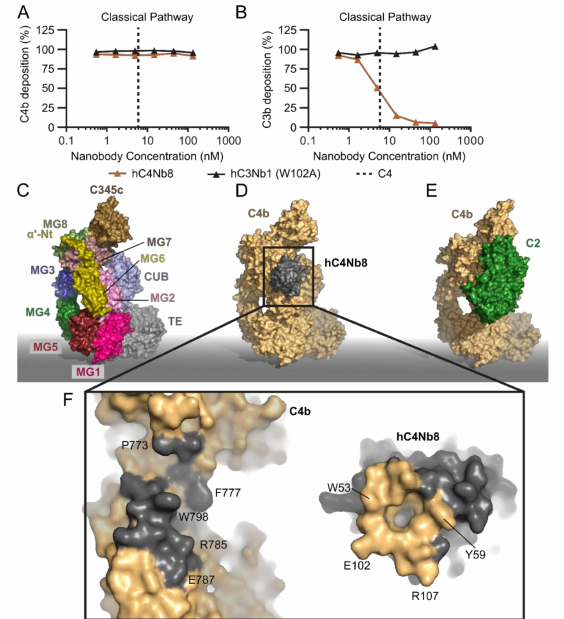
Figure 4. The inhibition mechanism of hC4Nb8. ( A , B ) Effect of hC4Nb8 on C3b and C4b deposition in 0.2% NHS where the CP was activated by heat aggregated IgG. hC4Nb8 potently inhibits C3b deposition without interfering with C4b deposition. The inactive hC3Nb1 W102A is included as control. ( C ) Domain structure of C4b (PDB entry 5JTW). Labels indicate the location of the individual domains. ( D ) the C4b:hC4Nb8 crystal structure (PDB entry 6YSQ). ( E ) the C4b2 atomic model based on SAXS data [106] highlights how hC4Nb8 binding to C4b prevents C2 from binding due to pronounced steric hindrance. ( F ) An open book view of the hC4Nb8:C4b interface, revealing formation of a hydrophobic pocket in the hC4Nb8 paratope accommodating C4b Trp798. Important residues mediating the interaction are labeled. In panels ( D – F ), C4b is shown in yellow, hC4Nb8 in gray, and C2 in